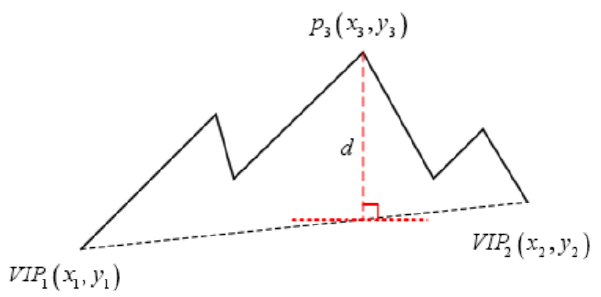
Figure 6. The basic idea of the PLR_VIP